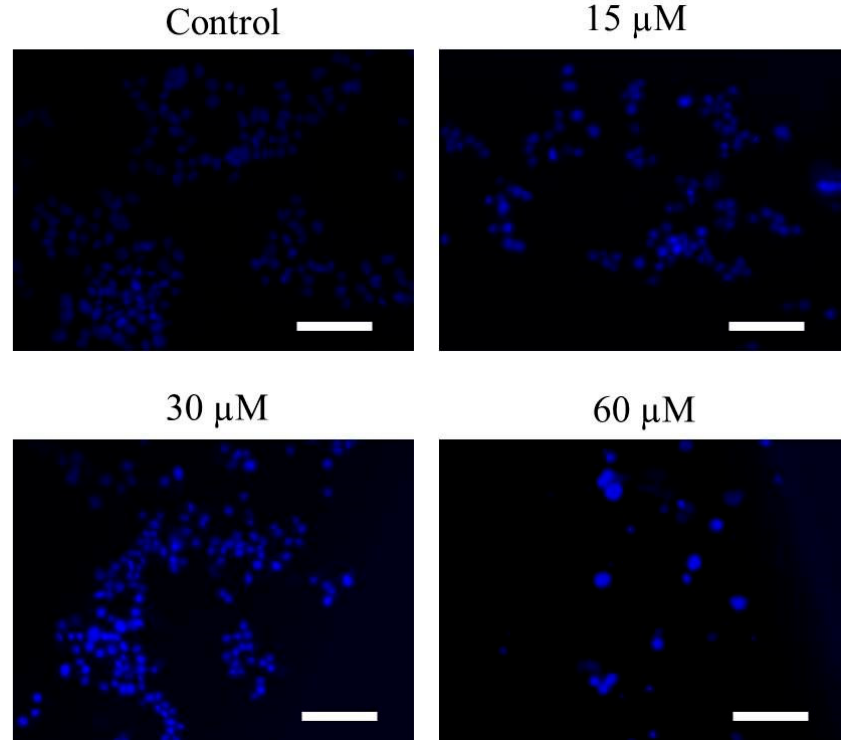
Figure 3. Changes in nuclear morphology observed through Hoechst-33342 staining in HepG2 cells post-24 h exposure. Scale bar = 100